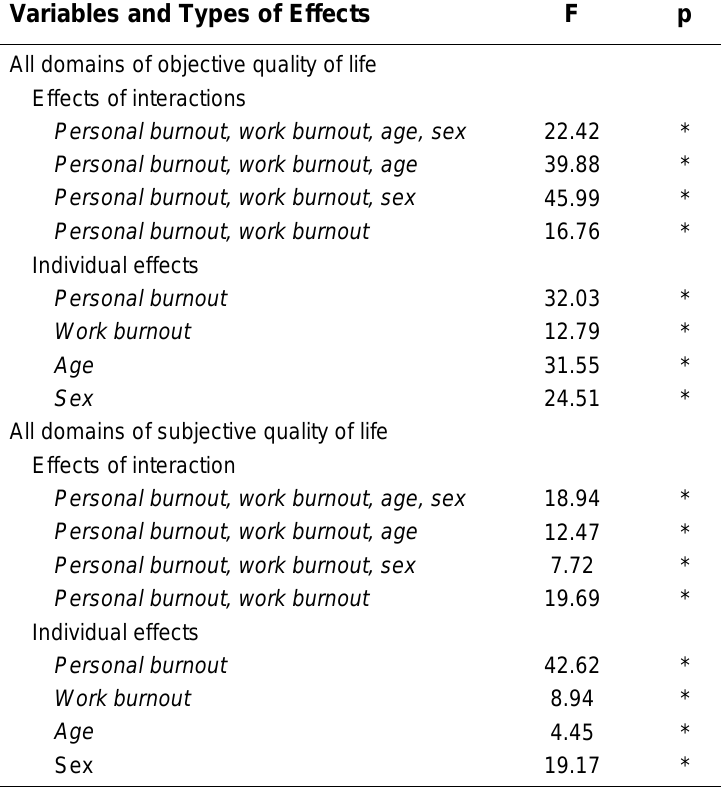
MANOVA Significance Tests for Effects of Personal and Work Burnout, Age, Sex, and All Domains of Objective and Subjective Quality of Life